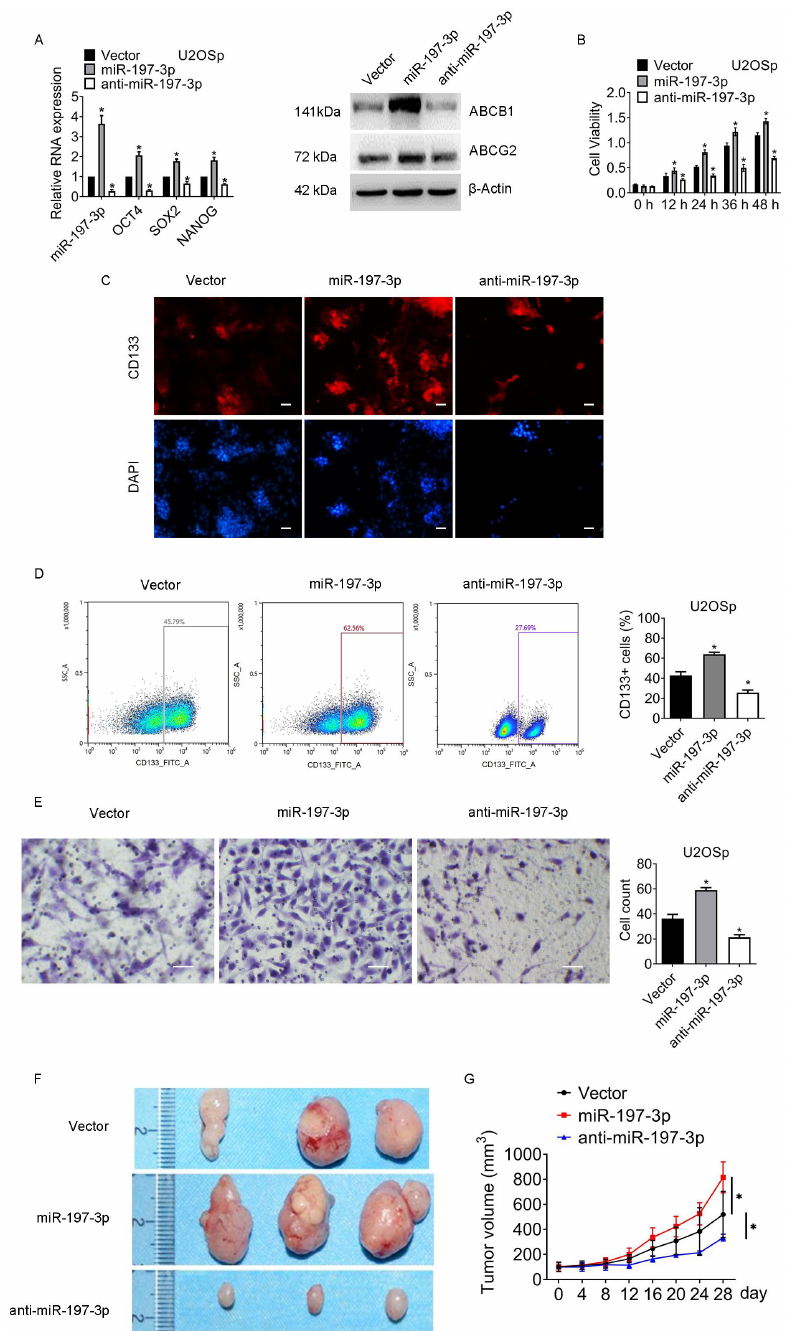
Figure 3. miR-197-3p plays an essential role in maintaining chemoresistance and stemness of osteosarcoma. Cells were transfected with vector, miR-197-3p, or anti-miR-197-3p. After 24 h, the cells were treated with 2 µM MTX for 24 h. The following in vitro experiments were then conducted: ( A ) The indicated genes expression was examined by qPCR and western blot. ( B ) The viability of the cells was assessed by MTT assay. ( C ) Representative images of immunofluorescence staining for CD133 are shown. Magnification, 400 × . ( D ) The representative images of CD133+ cells are shown. The quantity of CD133+ cells was measured by flow cytometry. SSC-A indicates Side-Scatter Area. ( E ) The migration of the cells was assessed by transwell assay. Magnification, 200 × . ( F , G ) Cells were stably transfected with vector, miR-197-3p, or anti-miR-197-3p. Mice received MTX treatment once a week for four weeks. Tumor volumes were calculated every four days. * p < 0.05; NS, no significance. Results represented the mean ± S.D. of three independent experiments. U2OSp, the parental